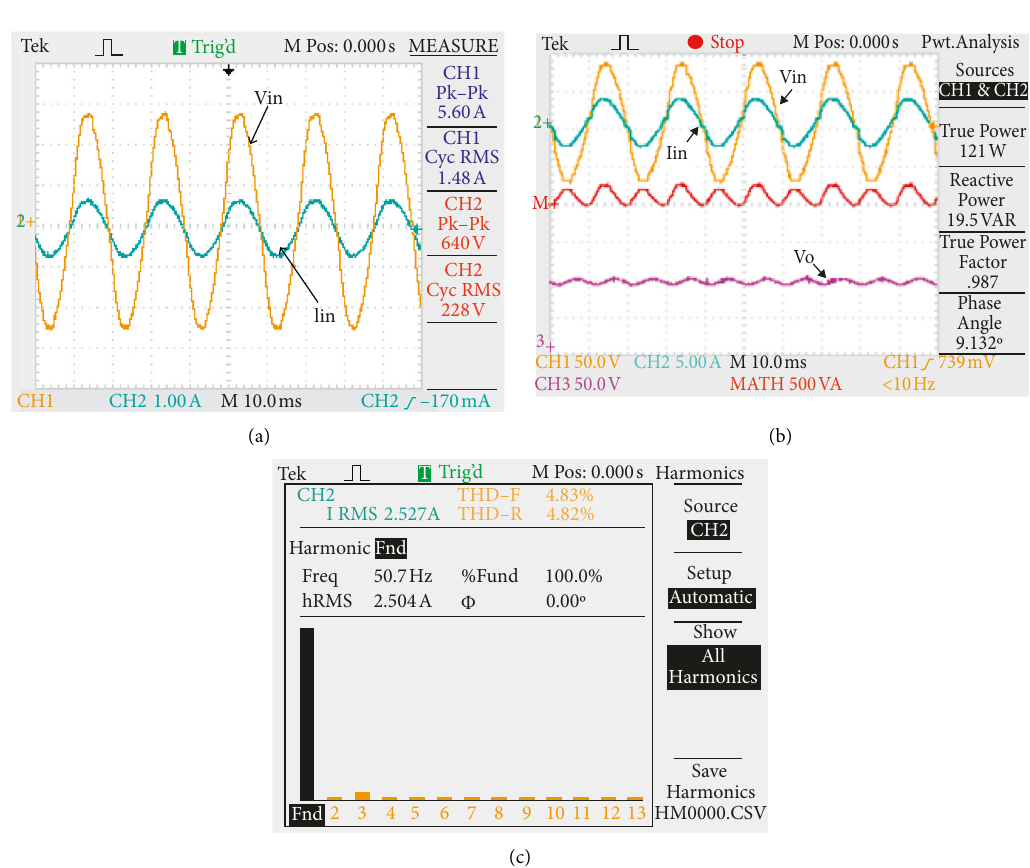
Figure 10: (a) Input voltage and input current waveform of 300W BLIL boost converter. (b) BLIL boost converter tested for 120W. (c) THD of input current for 300W at 110V input voltage.